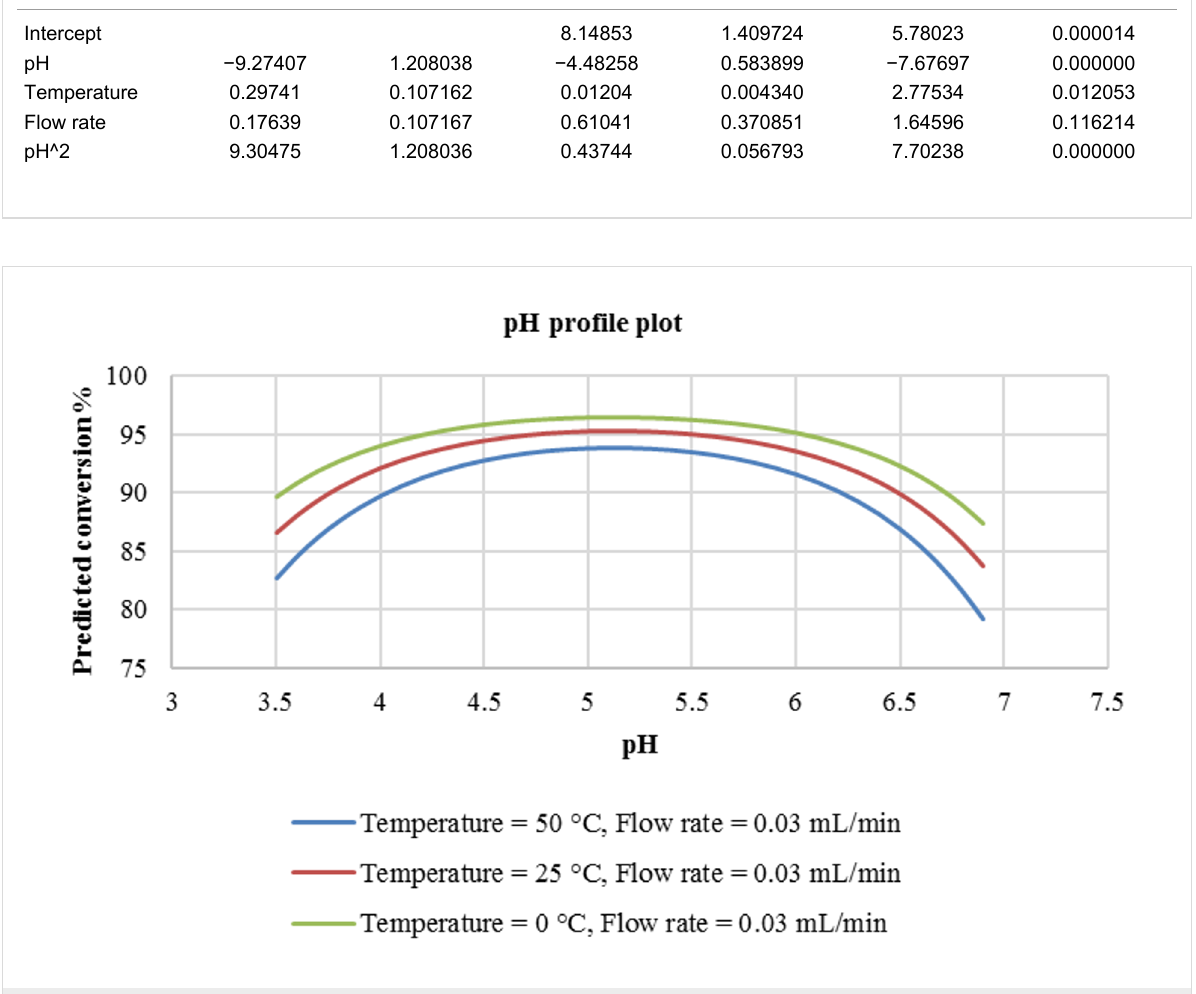
Figure 3: pH profile plot at a constant flow rate of 0.03